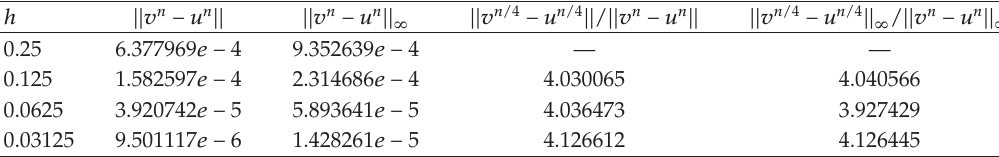
Table 4: The errors of numerical solutions at t (cid:9) 10 with τ (cid:9) 0 . 1 when p (cid:9) 4. h